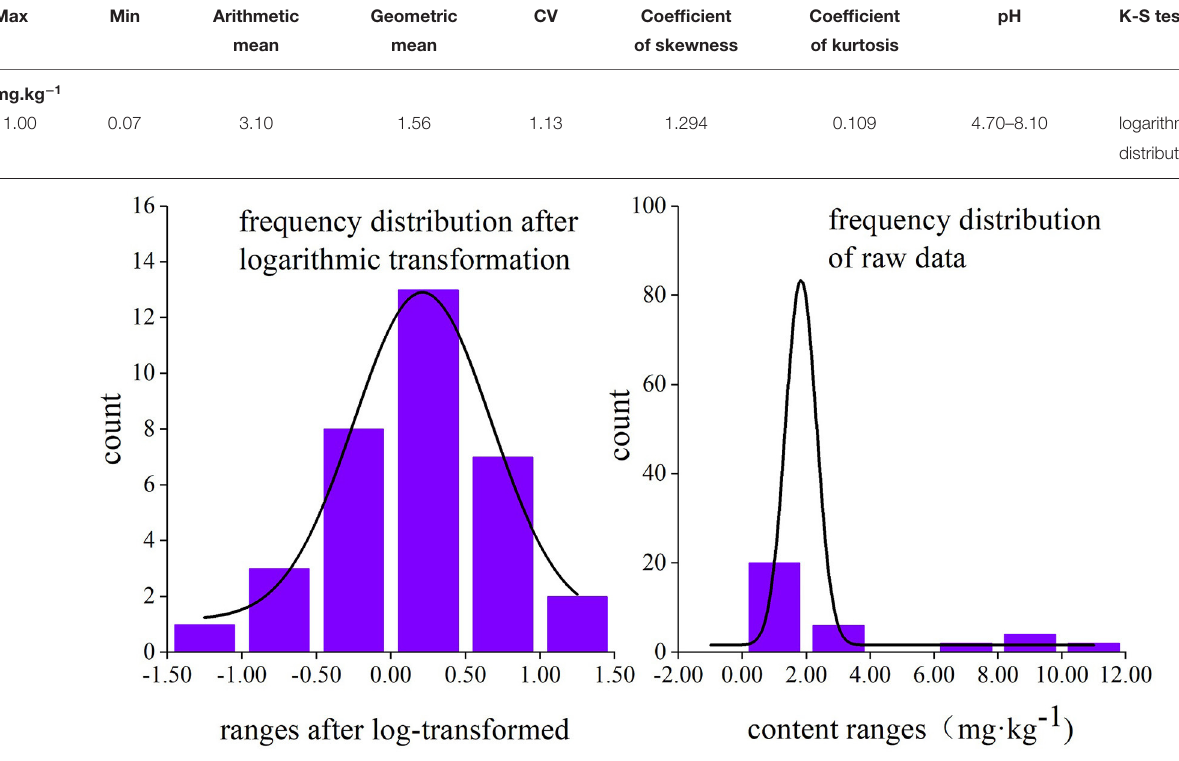
FIGURE 2 | Frequency distribution of antimony (Sb) on the surface layer of paddy soil.